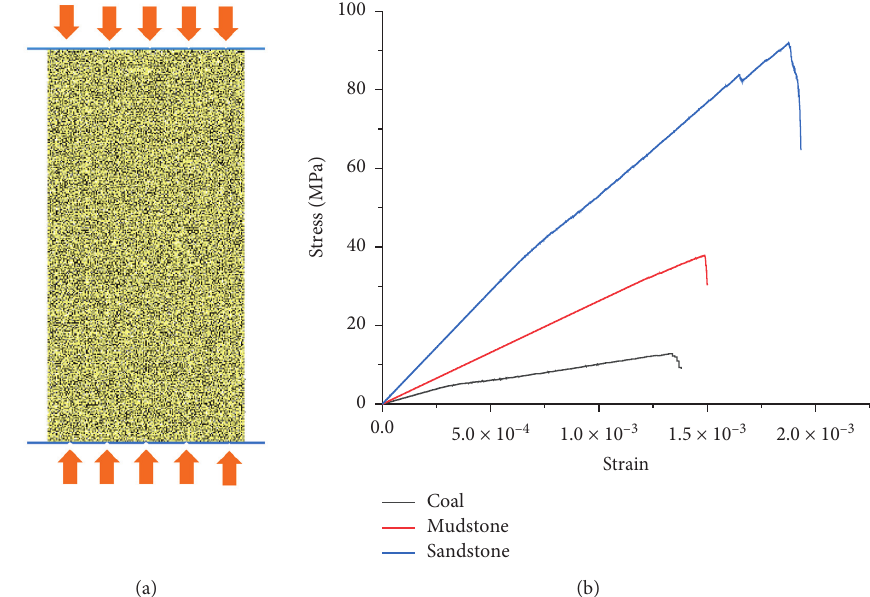
Figure 18: Simulated uniaxial compressive test (left) (a) and stress-strain curves for the rock (right) (b).